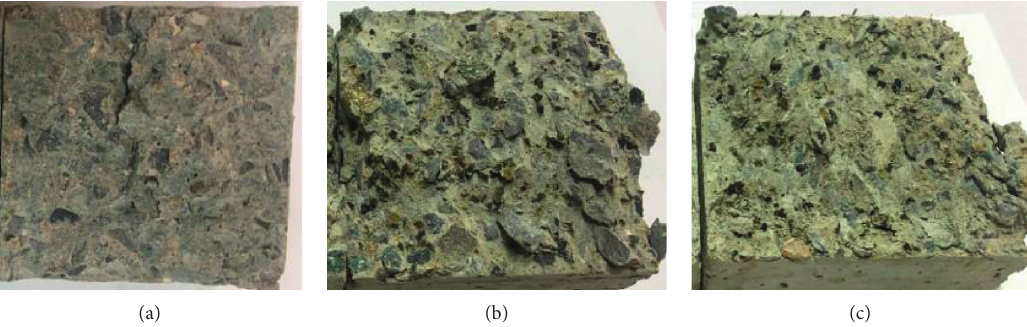
Figure 6: The influence of rubber particles and fibers on the concrete shear failure section. (a) C-0%-0%. (b) C-30%-0%. (c)